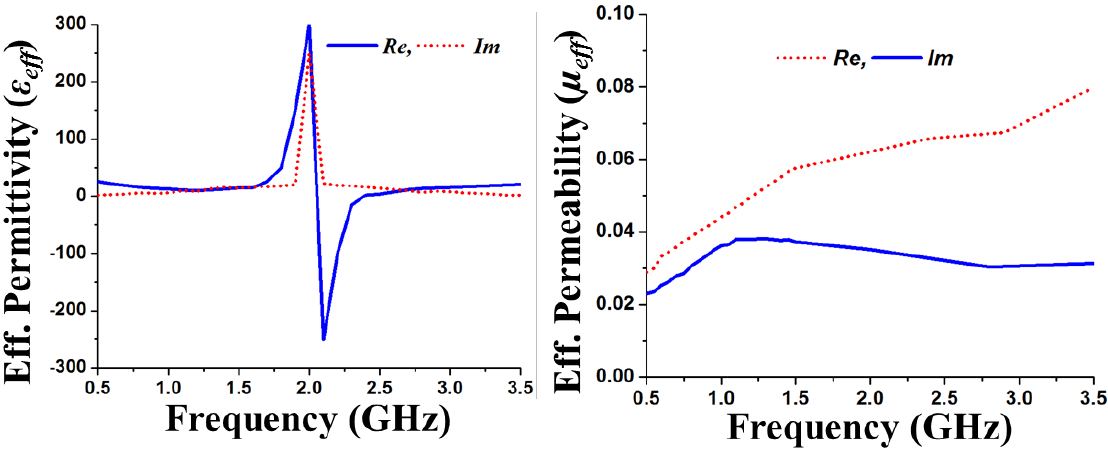
Figure 5. Effective permittivity and effective permeability of the metasurface superstrate structure (MSS) loaded antenna.